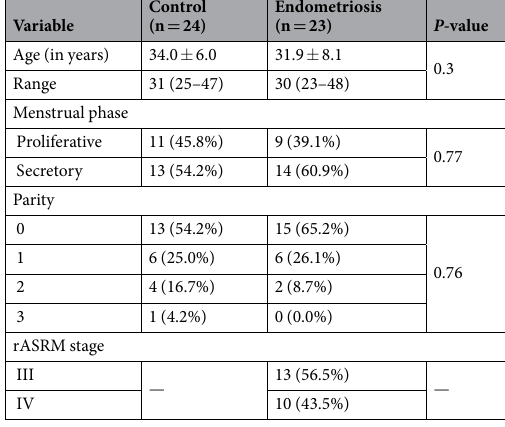
Table 1. The characteristics of the recruited